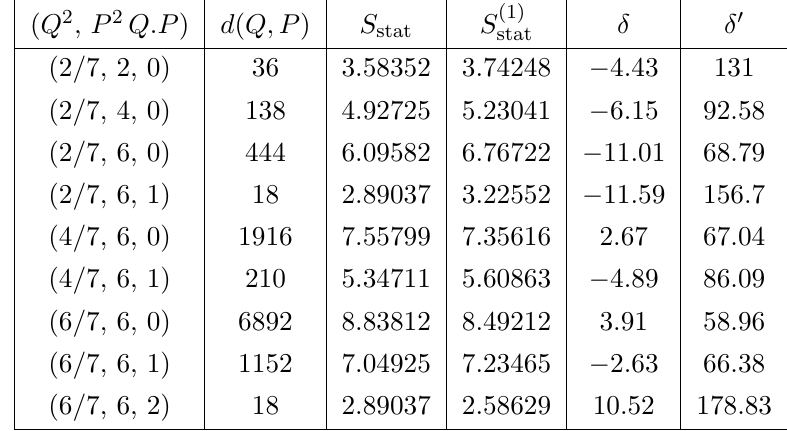
Table 8 . Comparison of the statistical entropy and statistical entropy at one loop for 7A orbifold.